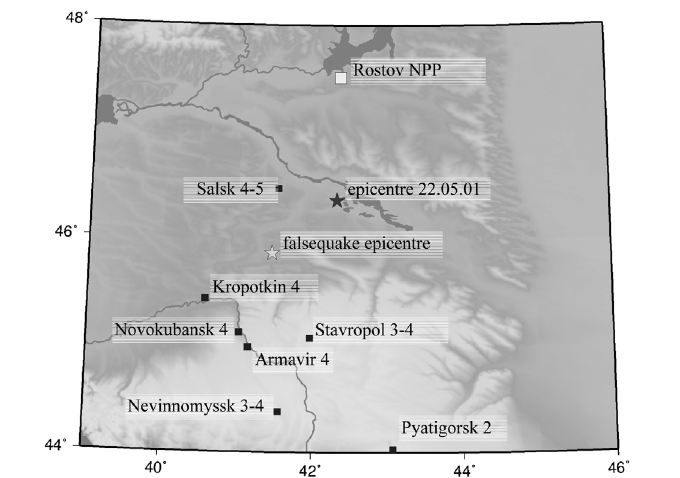
Fig. 10 . «Administrative» data filtering. Hypothetical event, which can appear in the regional catalogue after 100 years on the 22 May 2001 Salsk earthquake, if the only information which would survive on that event will be the one collected by Geophysical Service of RAS (Tatevossian et al. , 2002). Intensities at the sites are given according to the Geophysical Service,